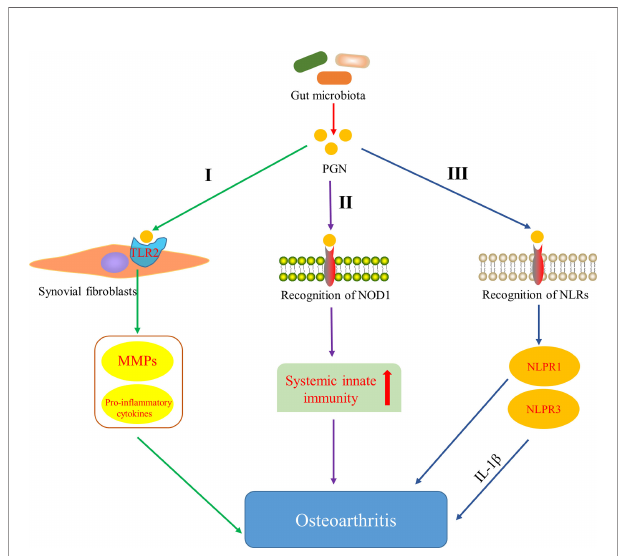
FIGURE 3 | Pathways of peptidoglycan (PGN) involved in OA. I PGN affects the development of OA by inducing the expression of matrix metalloproteinases (MMPs) and pro-in fl ammatory cytokines through activating Toll-like receptor 2 (TLR2) on synovial fi broblasts (Kyburz et al., 2003). II PGN affects the development of OA by recognizing NOD- like receptor 1 (NOD1) and promoting systemic innate immunity (Clarke et al., 2010). III PGN affects the development of OA by recognizing NOD- like receptors (NLRs), activating NLRP1 and NLRP3 in fl ammasome, and promoting the increase of pro-in fl ammatory